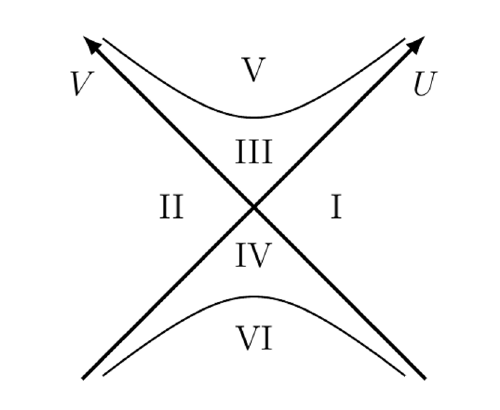
Figure 1 . Space-time diagram for the Lorentzian black hole (1.1). The cross defined by the equation UV = 0 is a horizon, while the metric possesses a physical singularity on the hyperbola UV = 1 .